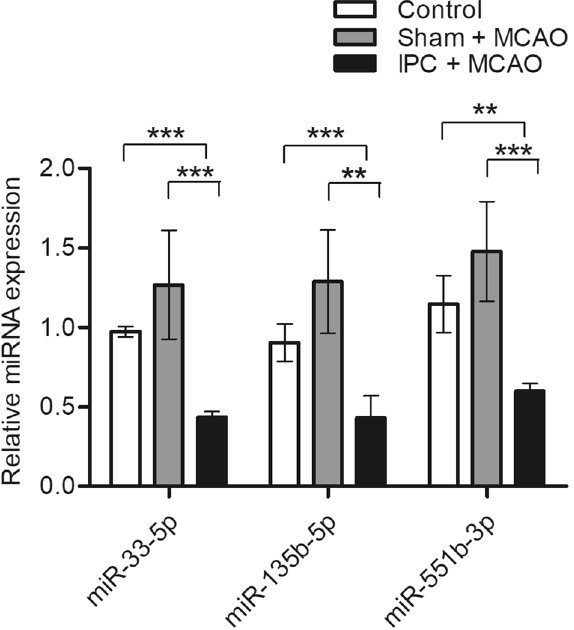
Figure 2. Downregulation of selected miRNAs after IPC. Expression patterns of selected miRNAs from the ipsilateral cortex were validated by RT-qPCR at 3 h after reperfusion and MCAO in both sham and preconditioned mice. Data are shown as mean ± standard deviation (n = 6). Statistical analyses were performed using t-tests (** = p < 0.01, *** = p < 0.001). Abbreviations: miRNA, micro ribonucleic acid; IPC, ischemic preconditioning; RT-qPCR, reverse transcription-quantitative polymerase chain reaction; MCAO, transient middle cerebral artery